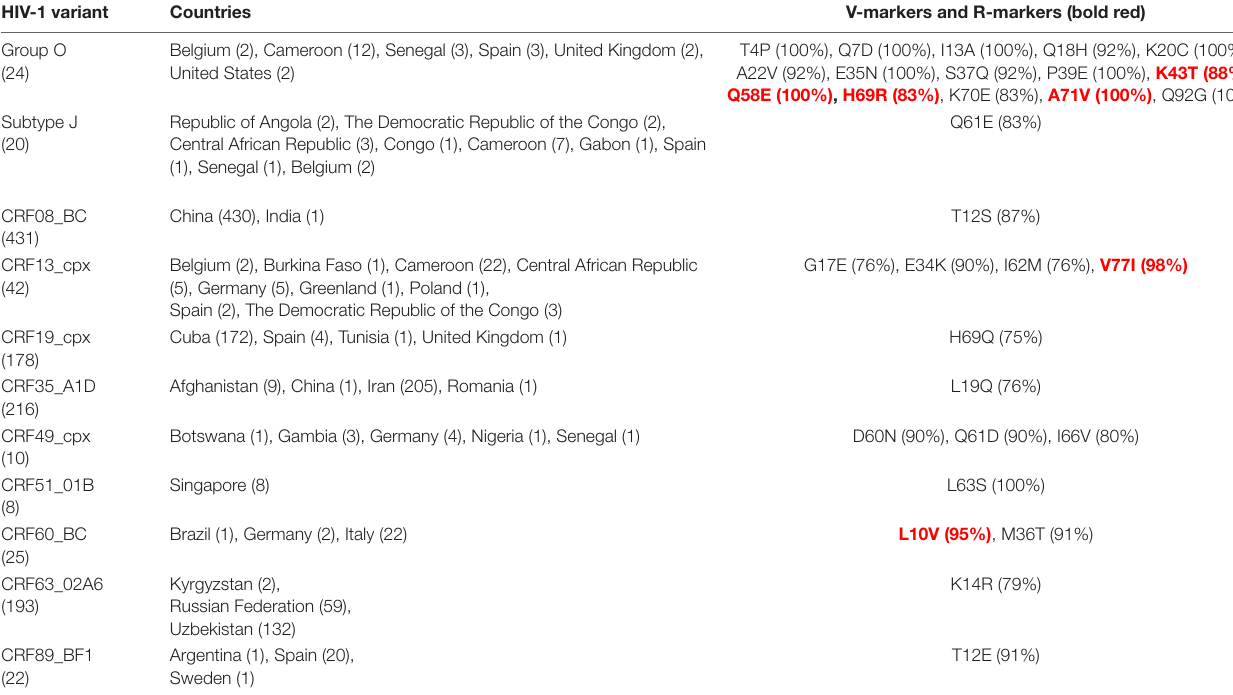
TABLE 2 | Single V-markers and R-markers in protease found across HIV-1 variants with > 5 LANL sequences. HIV-1 variant Countries V-markers and R-markers (bold red) Group O (24)